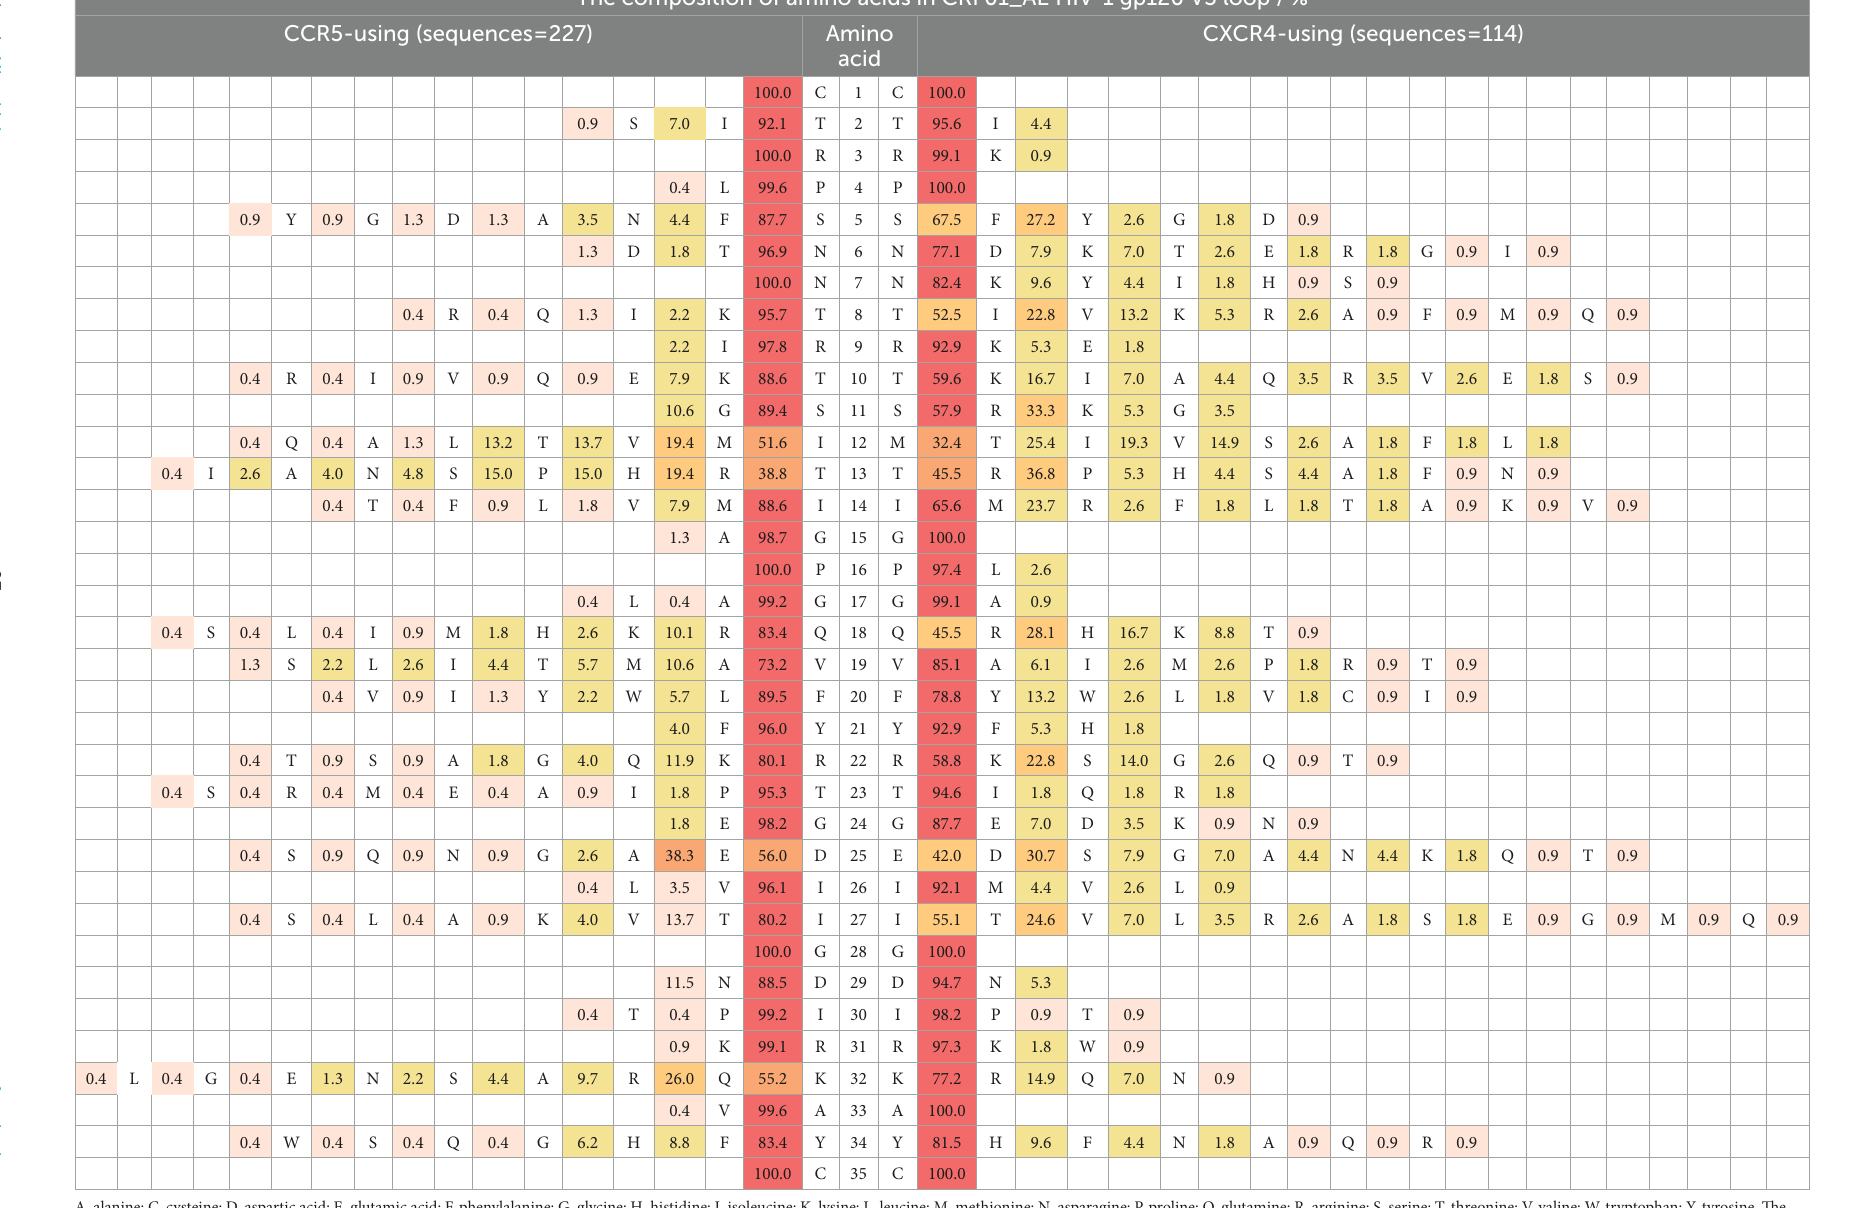
TABLE 3 The composition of amino acids in CRF01_AE HIV-1 gp120 V3 loop. The composition of amino acids in CRF01_AE HIV-1 gp120 V3 loop /